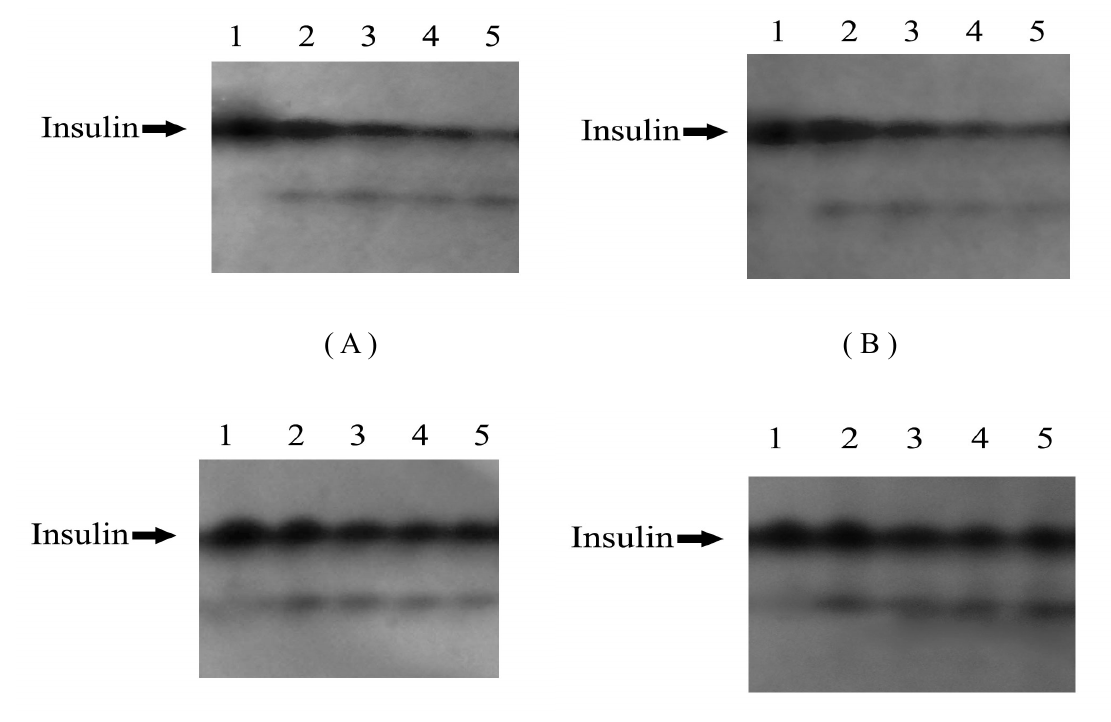
Figure 4. Effects of HP- β -CD and protamine on degradation of insulin induced by trypsin. Lanes 1-5 in (A) represent insulin incubated with trypsin at 37 ºC for 0, 15, 30, 45 and 60 min, respectively; Lanes 1-5 in (B) represent insulin incubated with trypsin and HP- β -CD at 37 ºC for 0, 15, 30, 45 and 60 min, respectively; Lanes 1-5 in (C) represent insulin incubated with trypsin and protamine at 37 ºC for 0, 15, 30, 45 and 60 min, respectively; Lanes 1-5 in (D) represent insulin incubated with trypsin, HP- β -CD and protamine at 37 ºC for 0, 15, 30, 45 and 60 min,